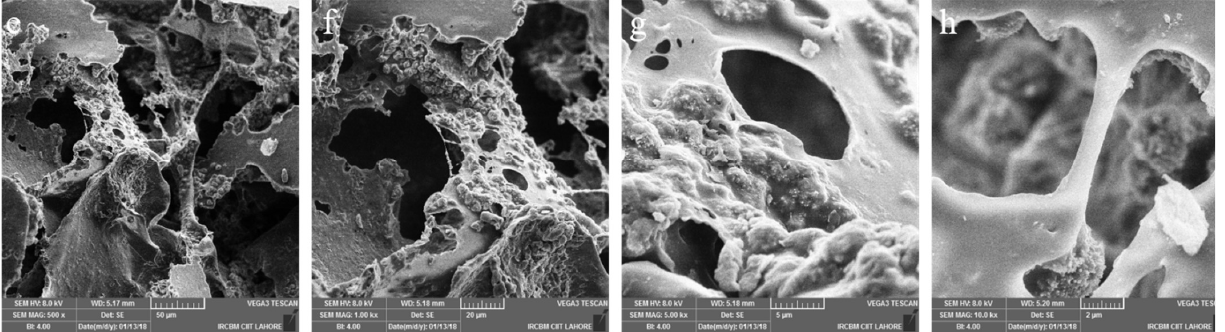
Figure 2. SEM images of PU scaffolds ( a – d ) and PU/HA scaffolds ( e – h ) at magnification (500×, 1 kx, 5 kx and 10 kx), indicating morphology, interconnectivity and dispersion of HA surface particles. In PU scaffolds no agglomeration of inorganic HA can be observed as its PU scaffold, where HA can be observed in PU/HA scaffolds.